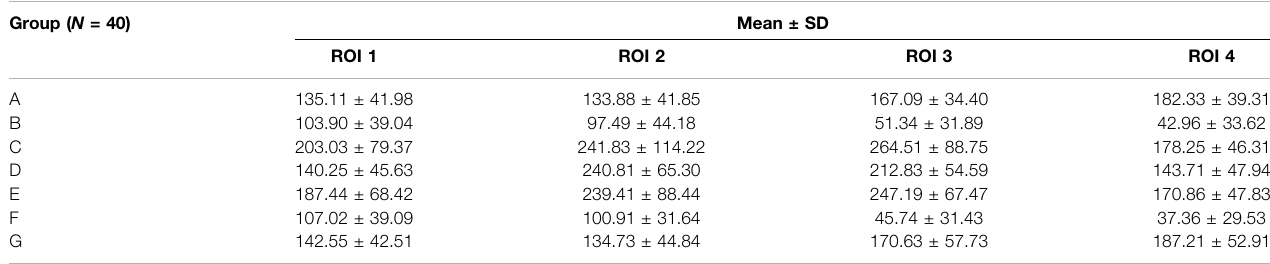
TABLE 4 | BMD of the region of interest in seven sagittal planes (mean ± SD,